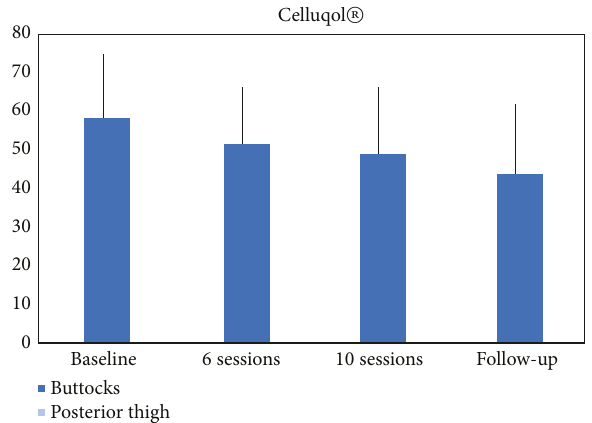
Figure 3: Improvement of quality of life by the representation of the Celluqol (cid:2)